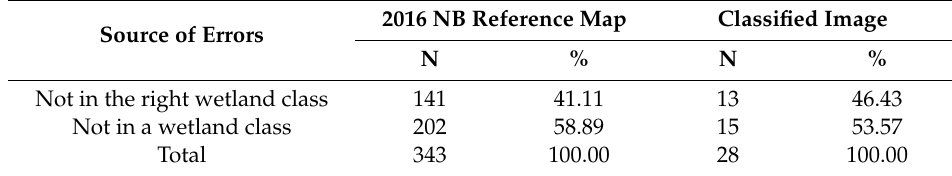
Table 15. Comparison between the 2016 NB reference map and the classified image for the distribution of the incorrectly identified in-situ GPS wetland validation sites as a function of the source of errors.